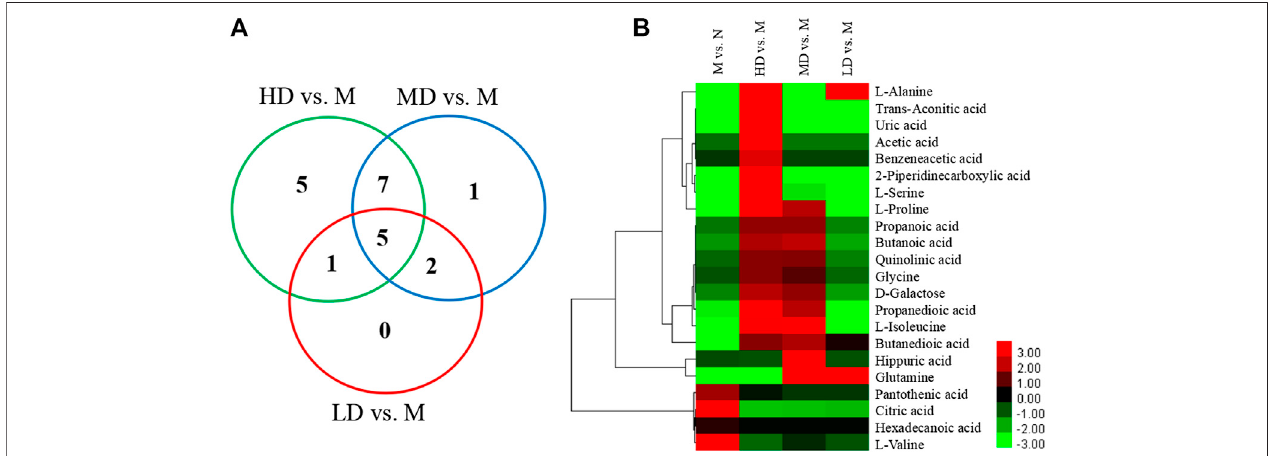
FIGURE 6 | The Venn diagram and heat map of identi fi ed differential metabolites in obese rats fed a high-fat diet. (A) The Venn diagram presents the number of differential metabolites that were changed in the HD, MD, and LD groups compared to the M group; (B) the heat map presents the differential metabolites between M group vs. N group, HD group vs. M group, MD group vs. M group, and LD group vs. M group.